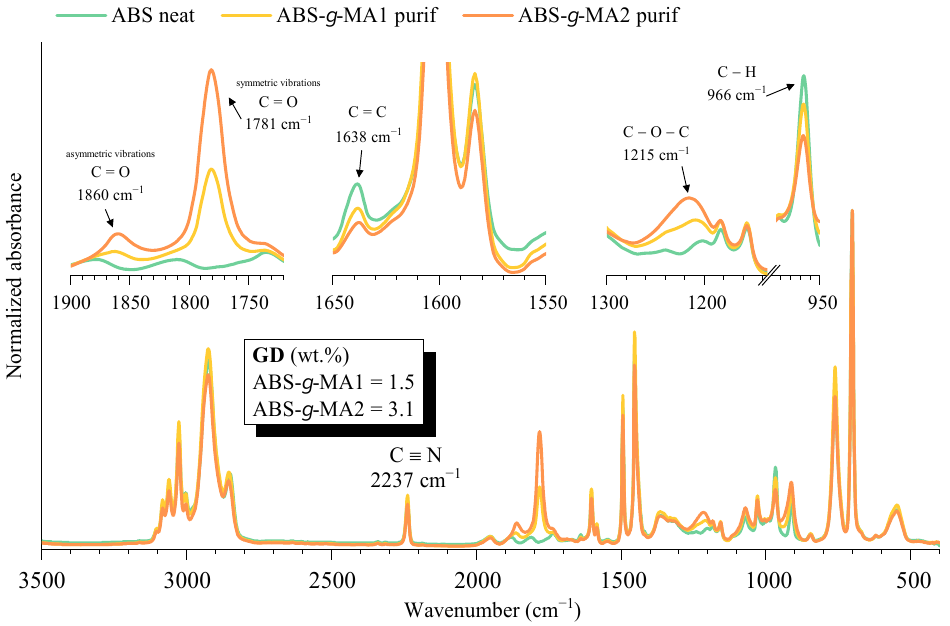
Figure 1. IR spectra of ABS ungrafted and grafted with maleic anhydride.